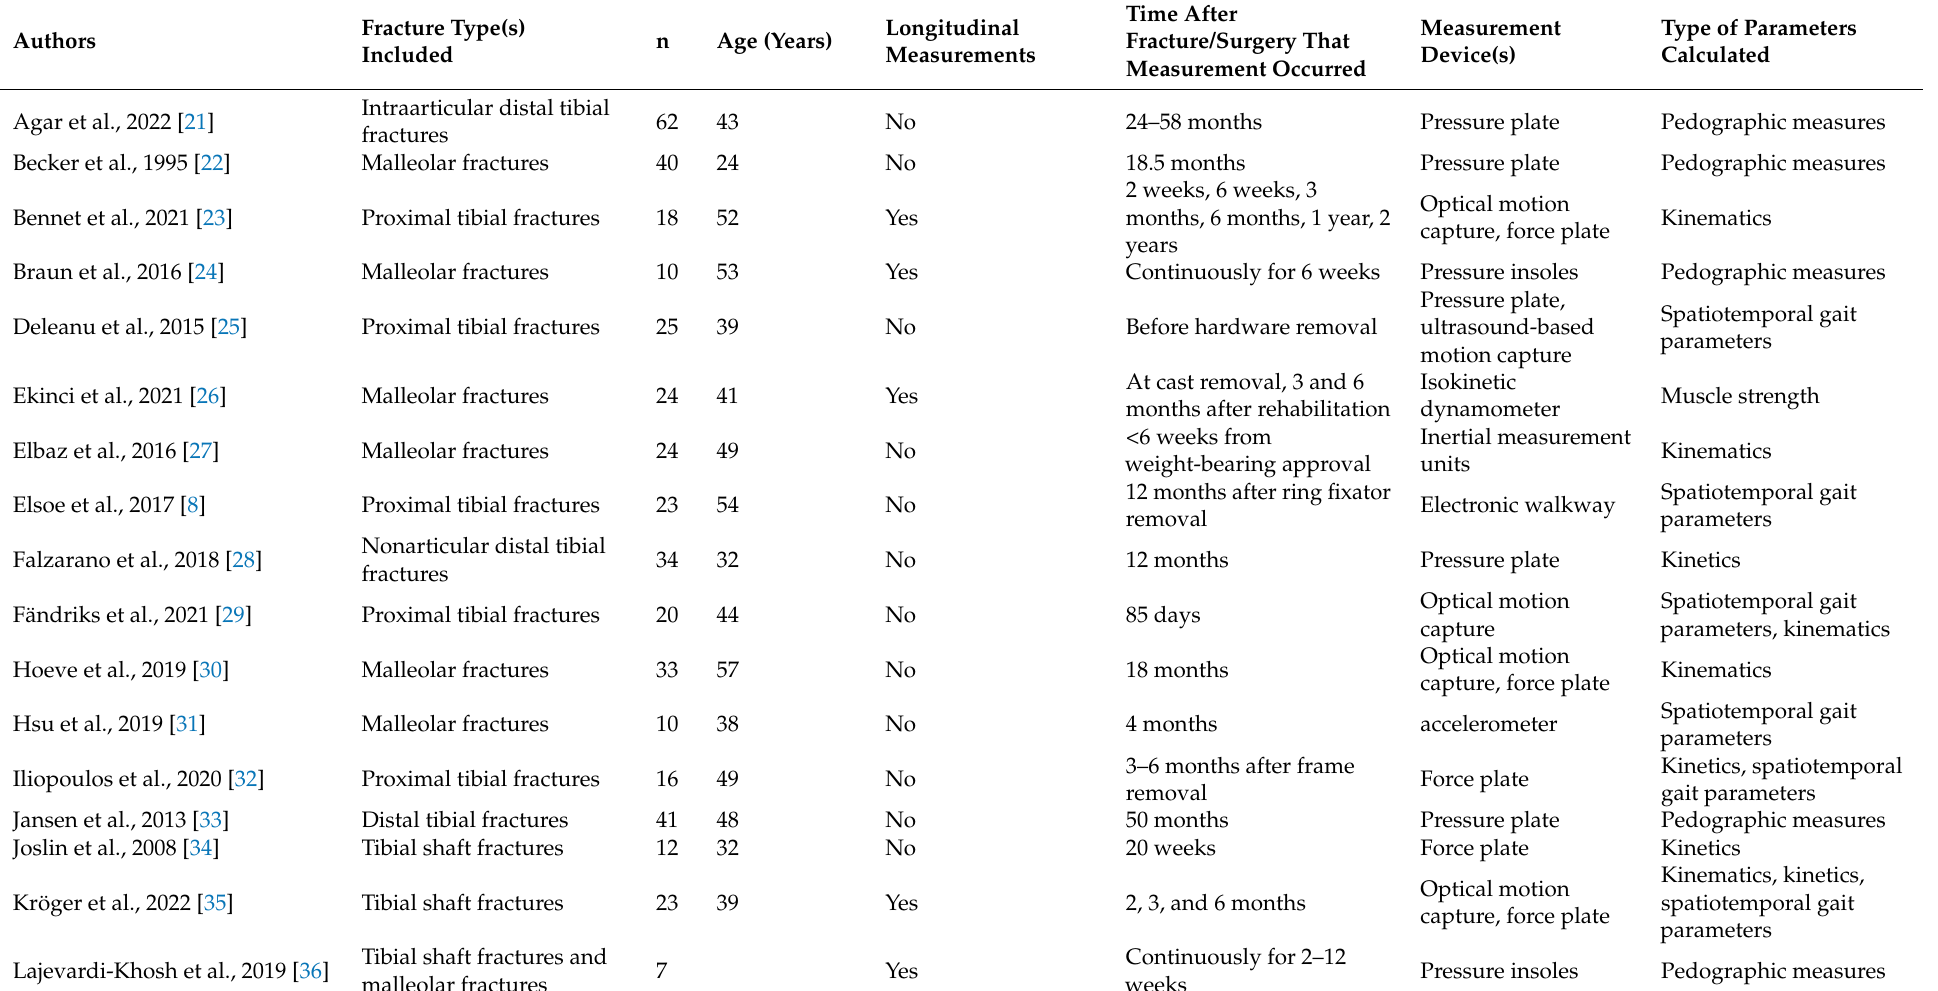
Table 1. Studies that measured gait-related parameters after lower leg